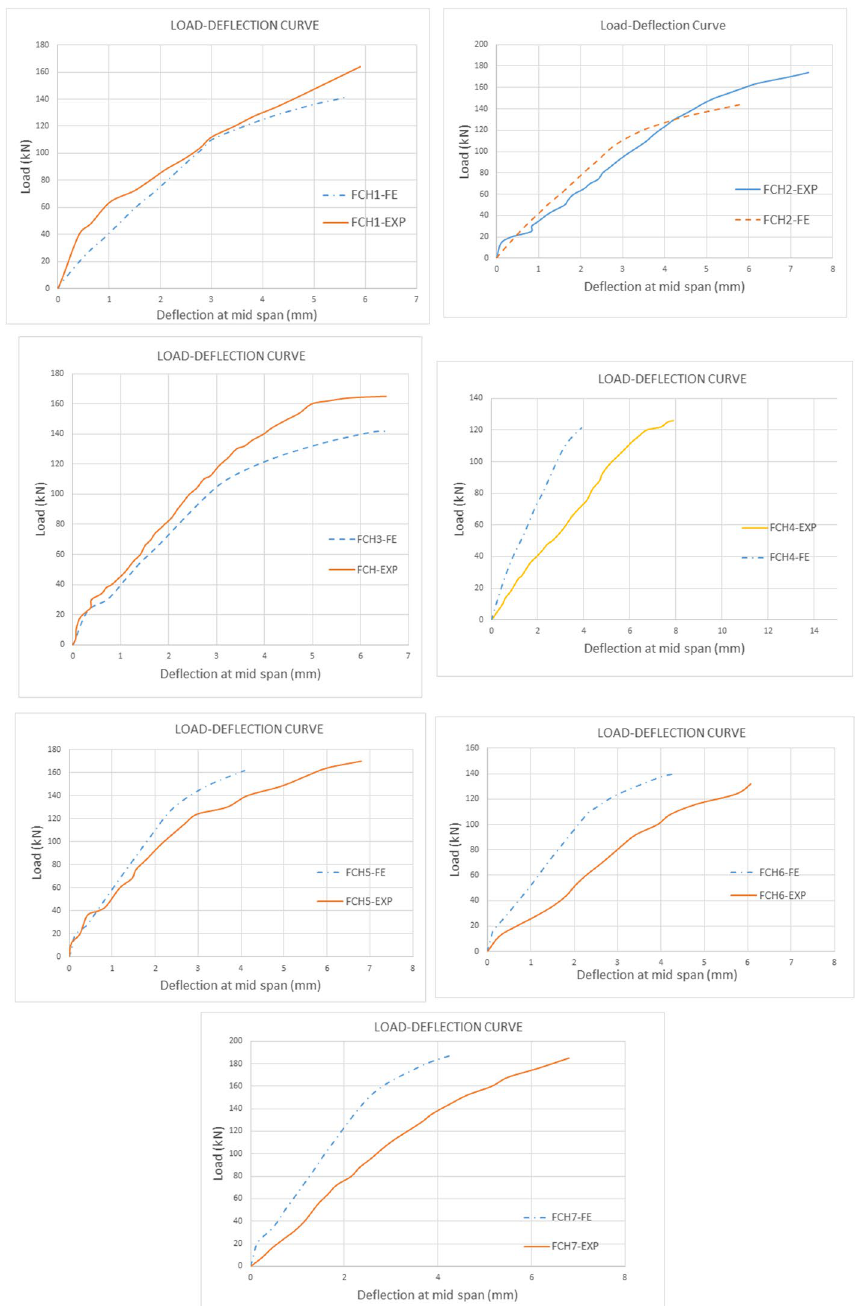
Fig. 22 Experimental and finite element